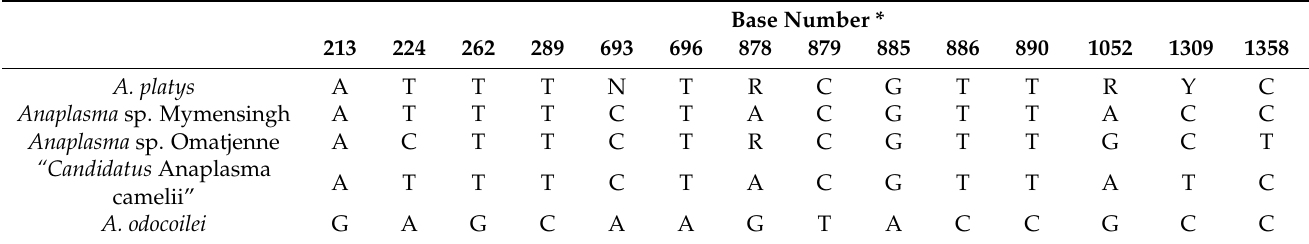
Table 5. Differentiating bases for Anaplasma platys and closely related